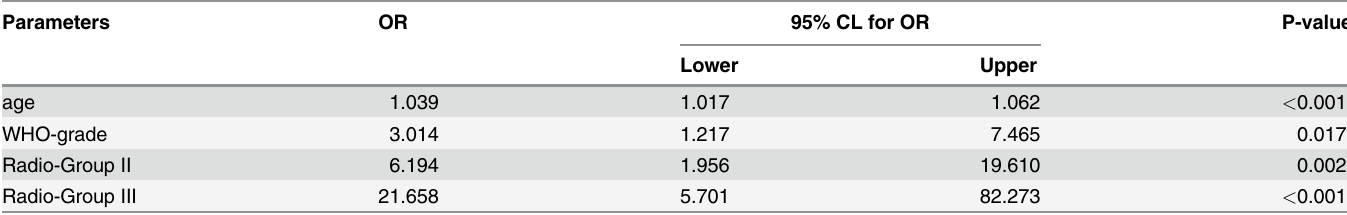
Table 3. Cox Regression analysis for the clinical and radiological parameters as predictors of unfavorable survival outcomes. Parameters OR 95% CL for OR P-value Lower Upper age 1.039 1.017